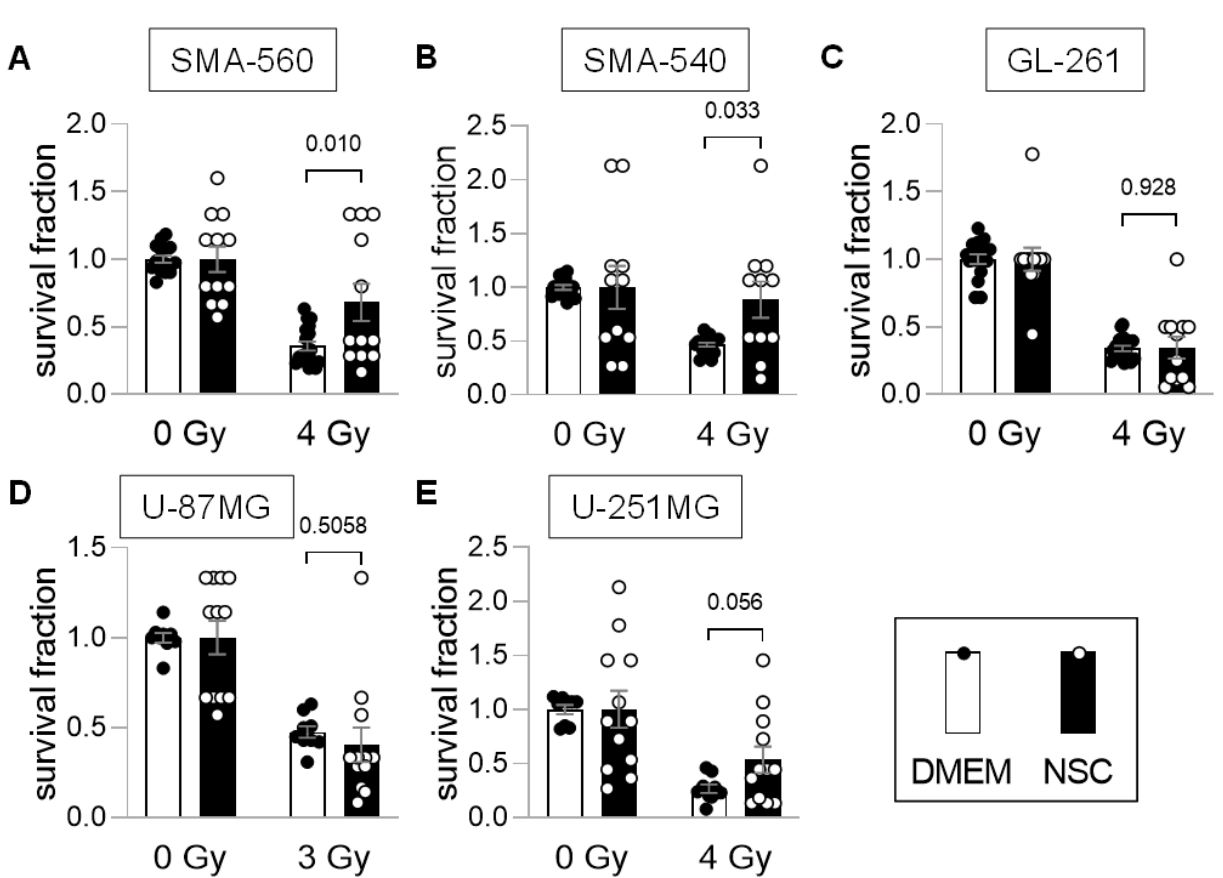
Figure 2. SMA-560, SMA-540 and U-251MG stem cell-enriched cultures are more radio-resistant than “differentiated” cultures. ( A – E ). Compared to standard culturing medium DMEM (closed circles; open bars), stem cell-inducing culture conditions with NSC medium (open circles; closed bars) increased clonogenic survival in ( A ) SMA-560, ( B ) SMA-540 and ( E ) (statistically non-significantly) U-251MG cells after irradiation. No statistically significant difference was observed in ( C ) GL-261 and ( D ) U-87MG cells (means ± SE of 3 experimental units with 4–6 observational units each). Numbers indicate error probabilities ( p values) as calculated by Welch-corrected two-tailed t